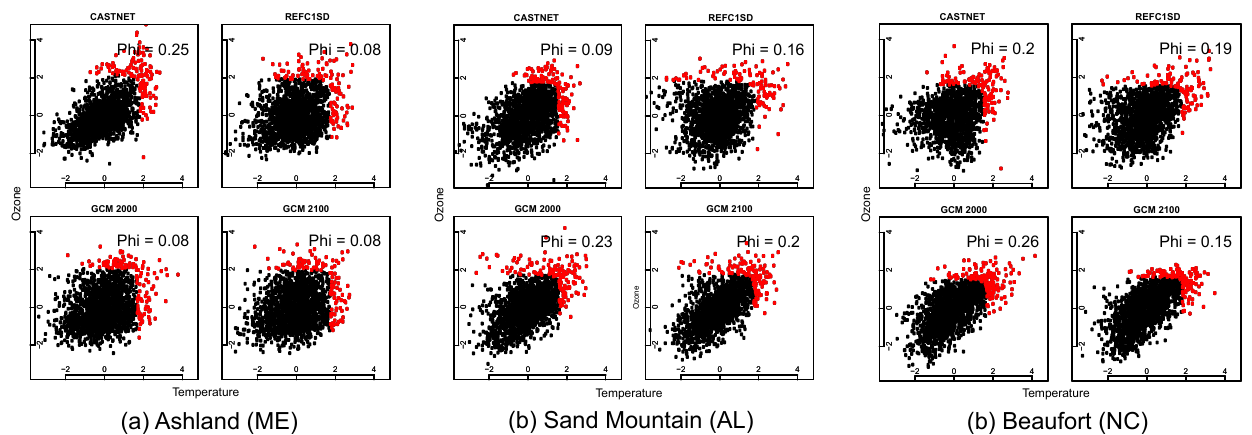
Figure 8. Normalized data. The scatter plots of temperature and ozone from selected CASTNET sites (or the corresponding grid point) for the CESM1 REFC1SD, the GCM200 or the GCM2100 simulation. (a) Ashland (ME), (b) Sand Mountain (AL), (c) Beaufort (NC). Extreme points are shown in red if the transformed points by using the ranks method are outside the unit circle (see the ranks method in Appendix B).